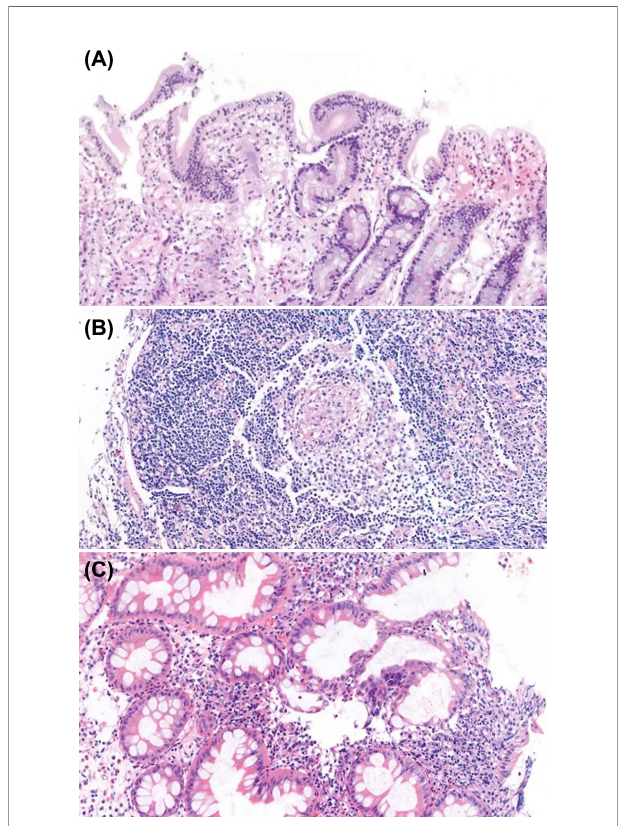
FIGURE 5 | Histopathologic fi ndings of endoscopic biopsies (H&E staining). (A) Duodenal biopsy with atrophy of villi, apoptotic bodies and increased intraepithelial lymphocytes, consistent with common variable immunode fi ciency. (B) Colonic biopsy with non-caseating granuloma in patient with X-linked inhibitor of apoptosis protein syndrome. (C) Colonic biopsy with cryptitis and crypt distortion in patient with